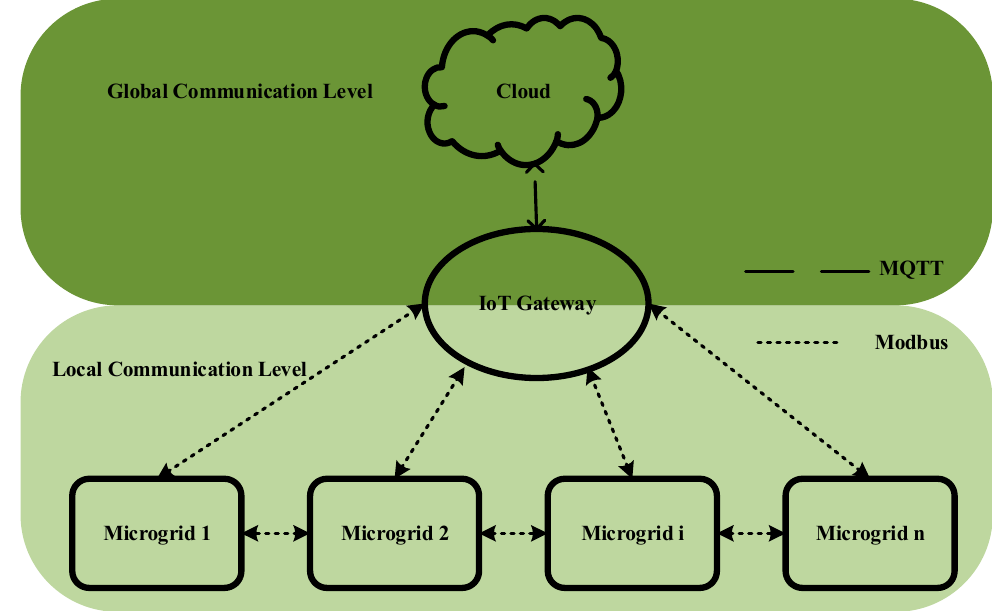
Figure 4. MMG Internet of Things (IoT) platform.